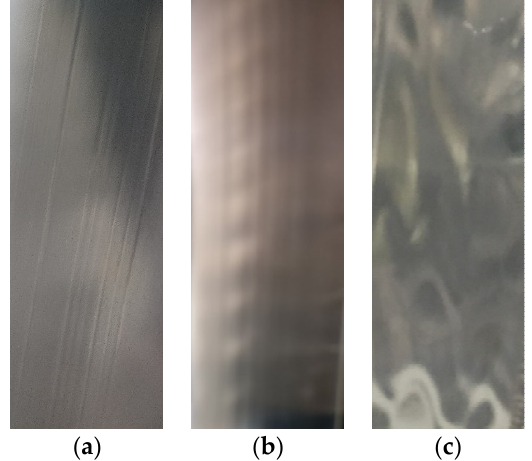
Figure 8. Images of the adhesive-HDPE co-extrudate in the molten state directly after exiting the die for various operating points showing ( a ) stable flow behavior, ( b ) unstable flow behavior (wave-type instabilities), and ( c ) highly unstable flow behavior (zig-zag-type instabilities). The image areas displayed comprise a size of approximately 80 mm × 30 mm each. Table 7. Overview of mass throughputs, dimensionless position of the interface, and visual assess- ment of flow instabilities of the co-extrudate for the operating points under investigation.